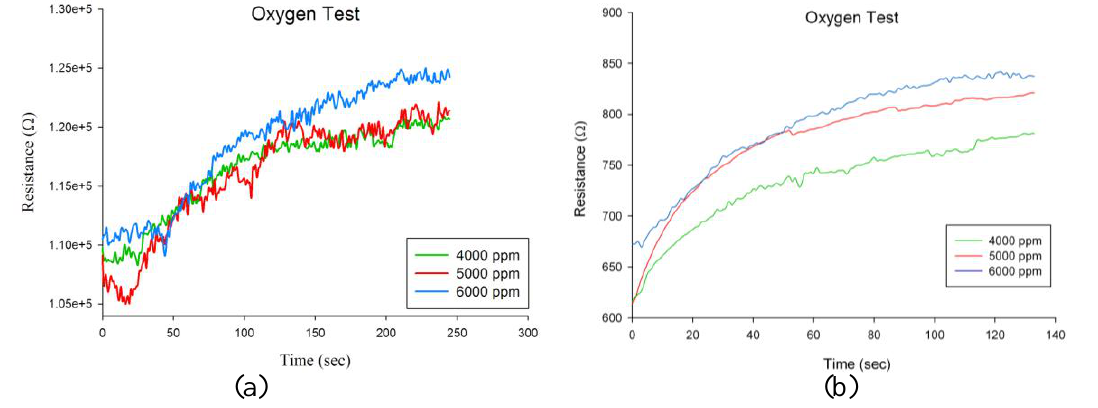
Figure 10. Temporal resistance response vs. different oxygen concentrations at a high temperature of 500  C with (a) a plain (non-porous) TiO film. The film thickness is 50 nm.